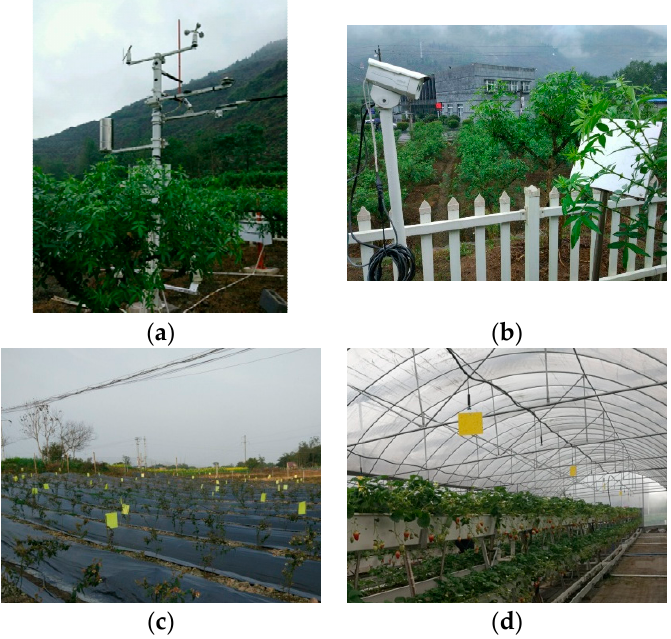
Figure 2. Illustration of meteorological station and yellow sticky trap ( a ) Meteorological station; ( b ) Equipment for trapping insects and collecting images; ( c ) Flower planting base; ( d ) Strawberry greenhouse.